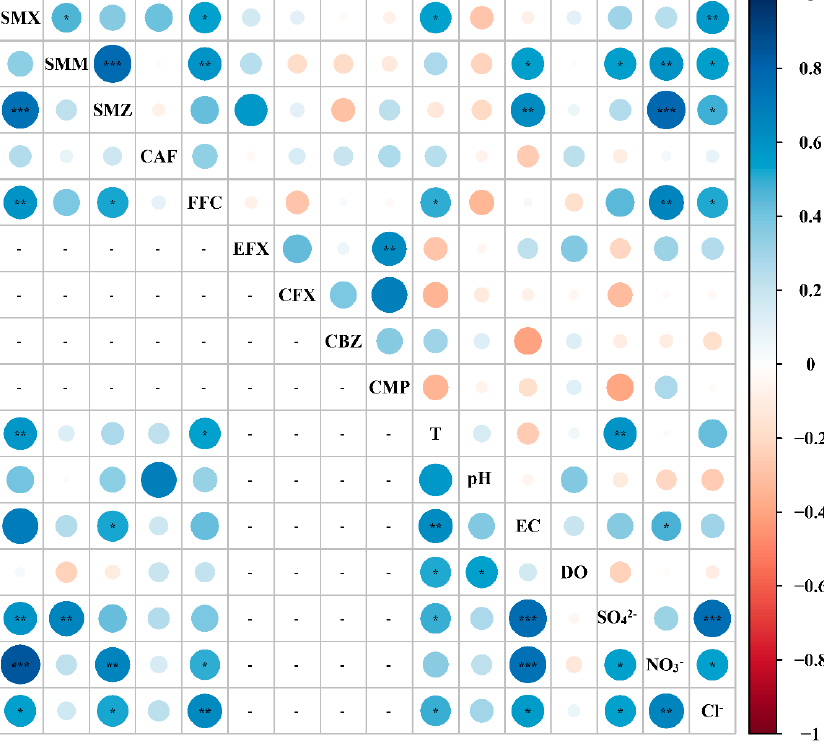
Figure 6. Spearman correlations among selected PPCPs and environmental parameters. The darker blue color indicates stronger positive correlation, and the darker red color indicates stronger negative correlation, * p < 0.05, ** p < 0.01, *** p < 0.001, FDR corrected (lower and left triangle: the dry season; upper and right triangle: the wet season). The larger the size of the circle, the greater the absolute value of the correlation coe ffi cient, and vice versa. ”-” represents no data.